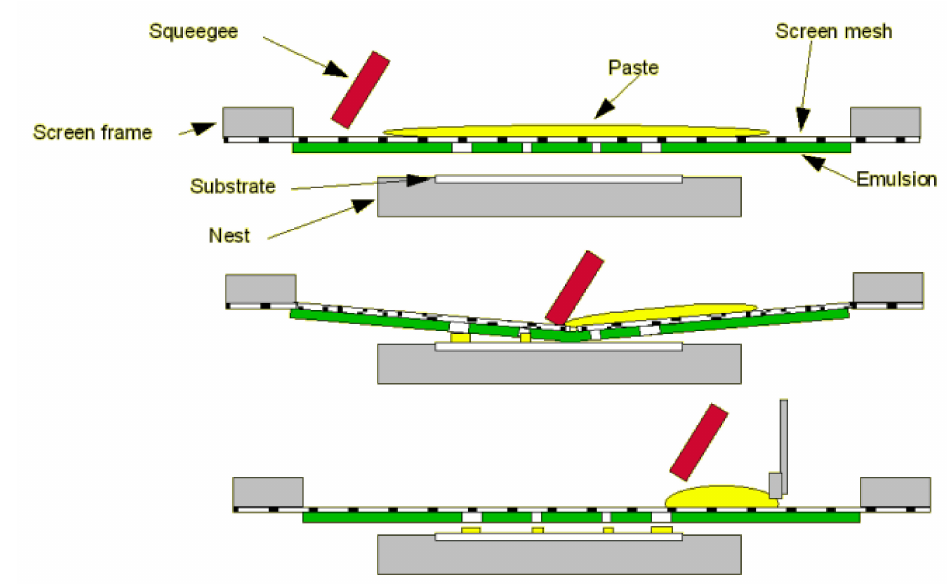
Figure 2. Basic process of screen-printing technology. Reprinted from [51] with permission of Gwent Group, Sun Chemical Advanced Materials, Sun Chemical, United Kingdom. http: // www.gwent.org /